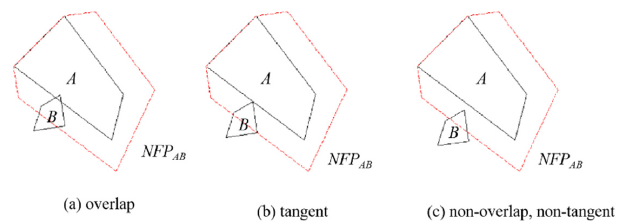
Figure 2. Relative positional relationship between polygons A and B.